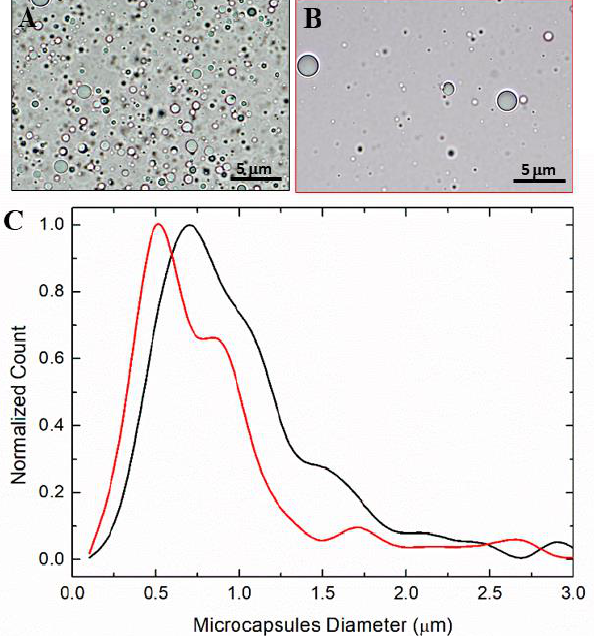
Figure 2. Optical microscopic images of RG mc prepared using 10 mg/mL RG + 50 μL soybean oil (SO): ( A ) after preparation and ( B ) (red box) after one-month storage. ( C ) Comparison of normalized size distribution of RG mc at day one (black) and after one month (red).